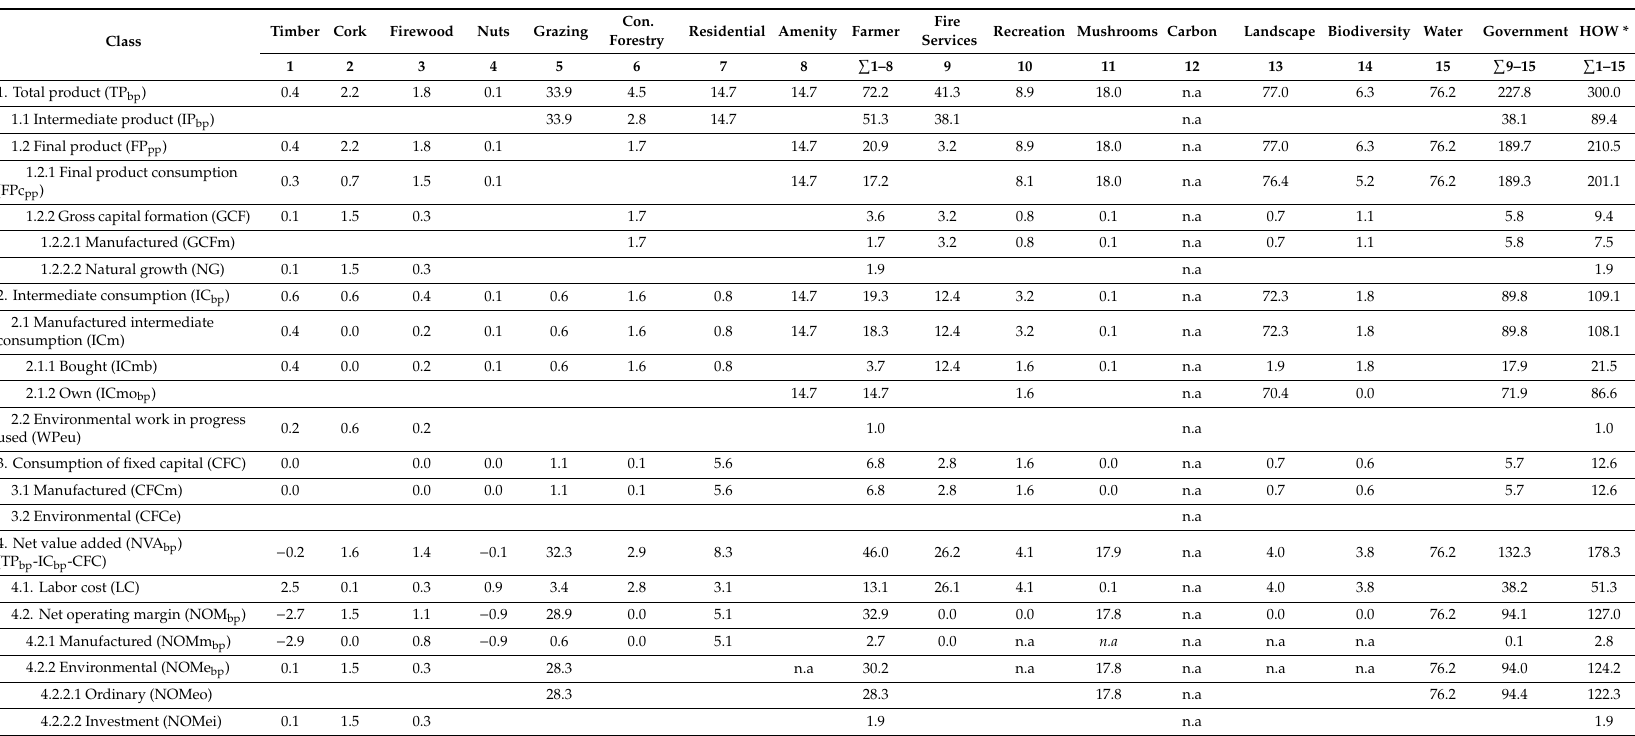
Table A1. Refined System of National Accounts total production account at basic prices applied to holm oak open woodlands in Andalusia (2010: € /